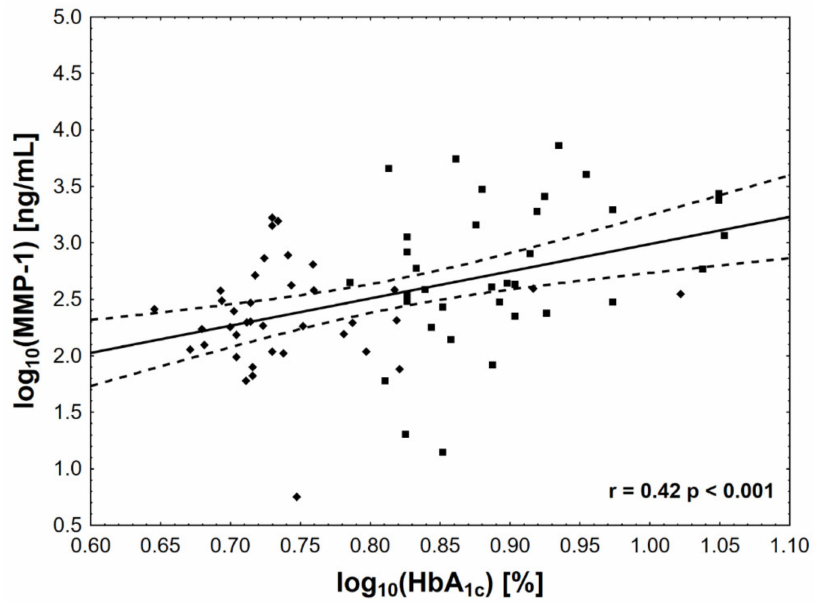
Figure 1. The associations between HbA 1c concentration and MMP-1 activity. The value of log HbA 1c of 0.78 corresponds to HbA 1c level = 42 mmol/mol (6.0%), log HbA 1c of 0.9—to HbA 1c level = 64 mmol/mol (8.0%), and log HbA 1c of 1.0—to HbA 1c level = 86 mmol/mol (10%).